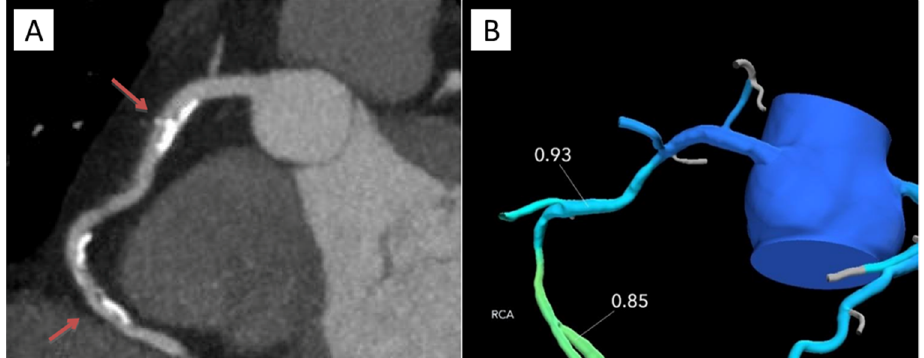
Figure 5. Study patient case. A 48-year-old male with a family history of coronary artery disease, dyspnea on exertion and atypical chest pain underwent coronary CTA. Multiplanar reformat of coronary CTA of the RCA ( A ), and FFR CT ( B ). RCA demonstrated proximal and mid-calcified and non-calcified intermediate (50–70%) stenoses (red arrows) without evidence of lesion-specific ischemia. FFR CT values distal to the proximal and mid RCA stenoses were 0.93 and 0.85, respectively. The patient safely avoided ICA and has been asymptomatic in follow-up on optimal medical therapy. FFR CT, fractional flow reserve derived from coronary computed tomography angiography (CTA) datasets; RCA, right coronary artery; ICA, invasive coronary angiography.